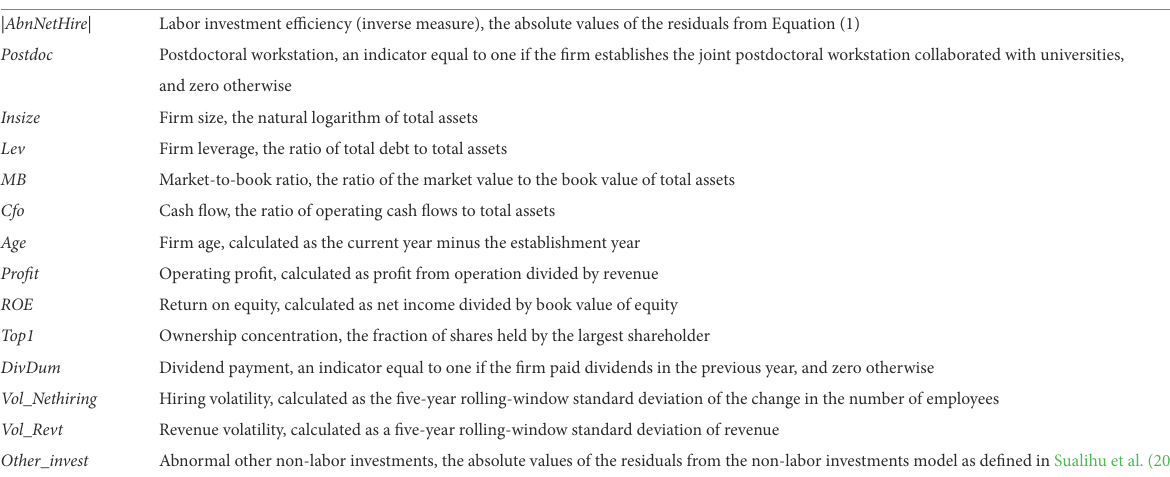
TABLE 1 Variable definitions.